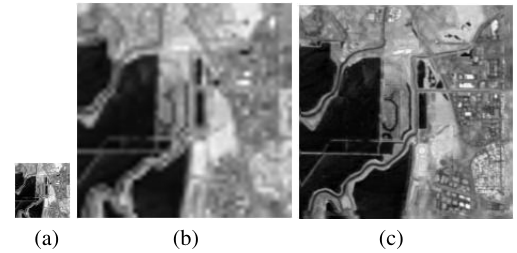
Figure 4: SR results on AVIRIS HS Band 100 for q = 4 (a) LR image 50 × 50 , (b) Bicubic interpolation, and (c) Proposed approach.